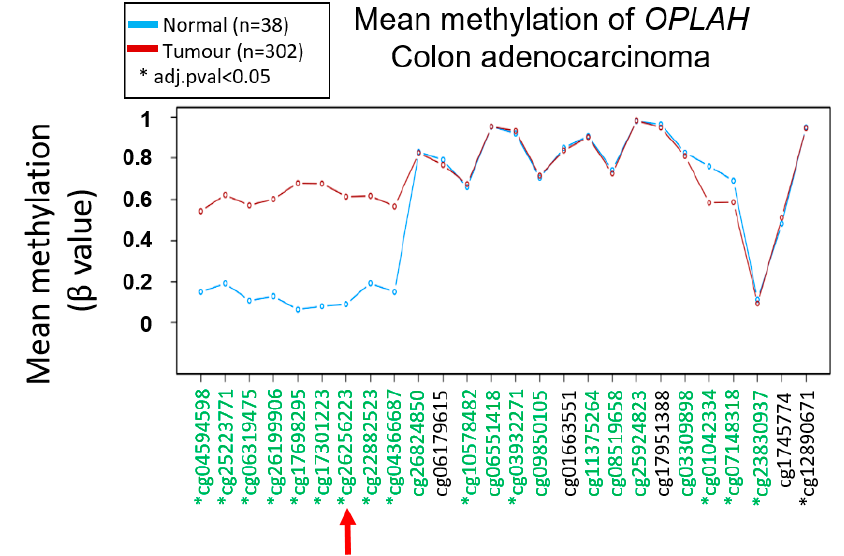
Figure 7. In silico validation of OPLAH methylation in the TCGA COAD dataset. The red arrow indicates the specific hypermethylated locus identified in our study, which is also found to be significantly hypermethylated in the tumour compared to the normal colon.